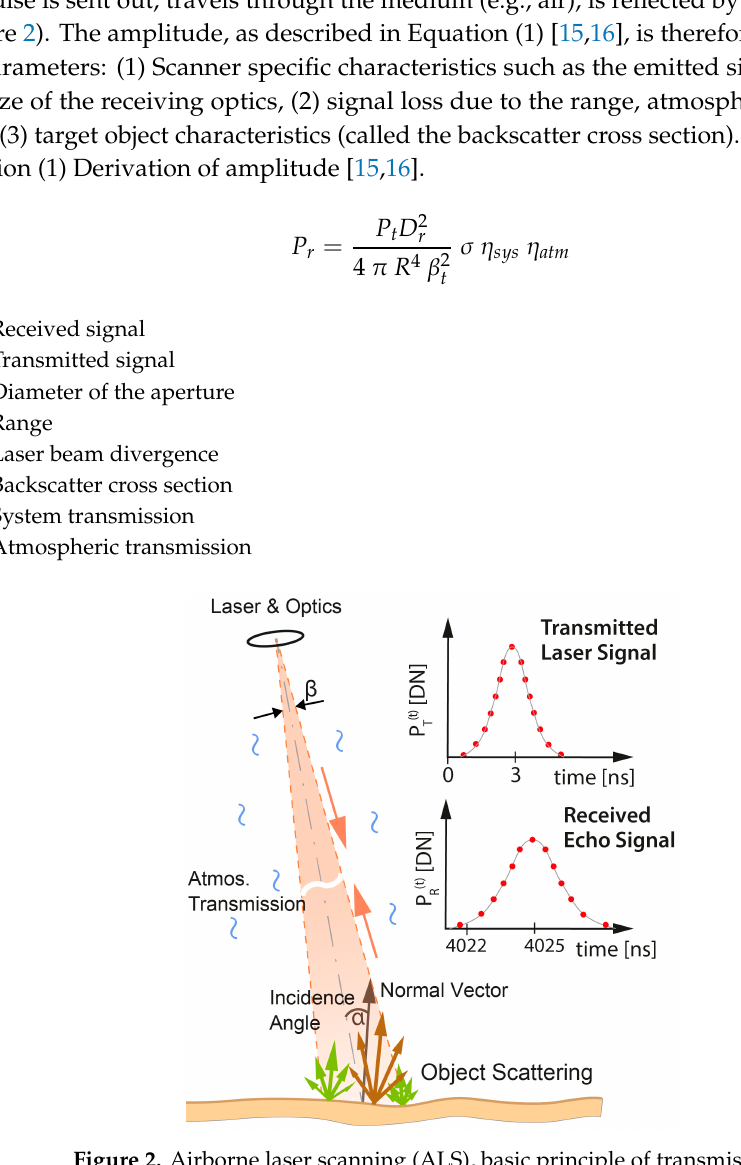
Figure 2. Airborne laser scanning (ALS), basic principle of transmission.